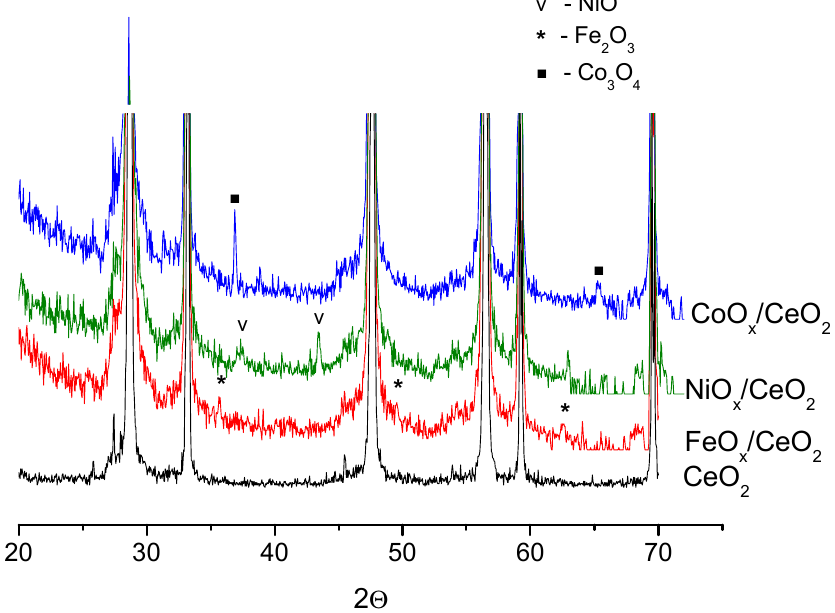
Figure 4. XRD patterns of MeO x /CeO 2 (Me = Fe, Co, Ni) samples. Me concentration—0.86–0.91 wt.%. Table 5. Me/Ce (Me = Ni, Fe, Co) atomic ratios in the surface layers (XPS) of different MeO x /CeO 2 samples, normalized rates of isotope exchange on MeOx and CeO 2 ( R I (Me,Ce) and R II (Me,Ce) ) and rates of reactions of stages 1 and 2 (Scheme 1) of isotope exchange on different sites (( r 1 = r − 1 ) (Me,Ce) and ( r 2 = r − 2 ) (Me,Ce) ). Me concentration—0.86–0.91